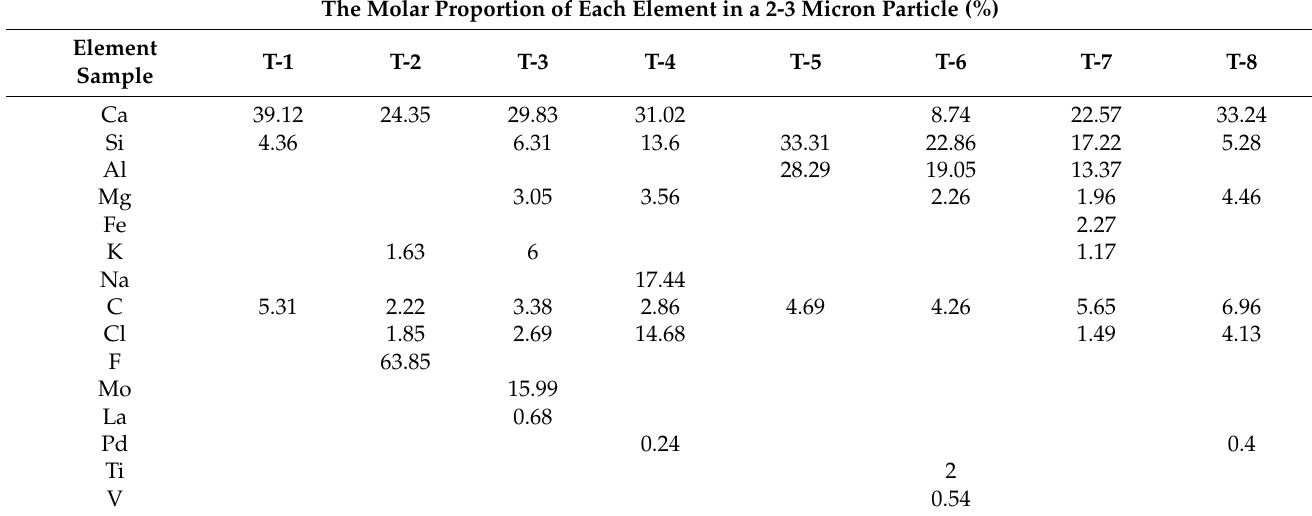
Table 1. The molar proportions of each element in each particle size range of 2~3 µ m